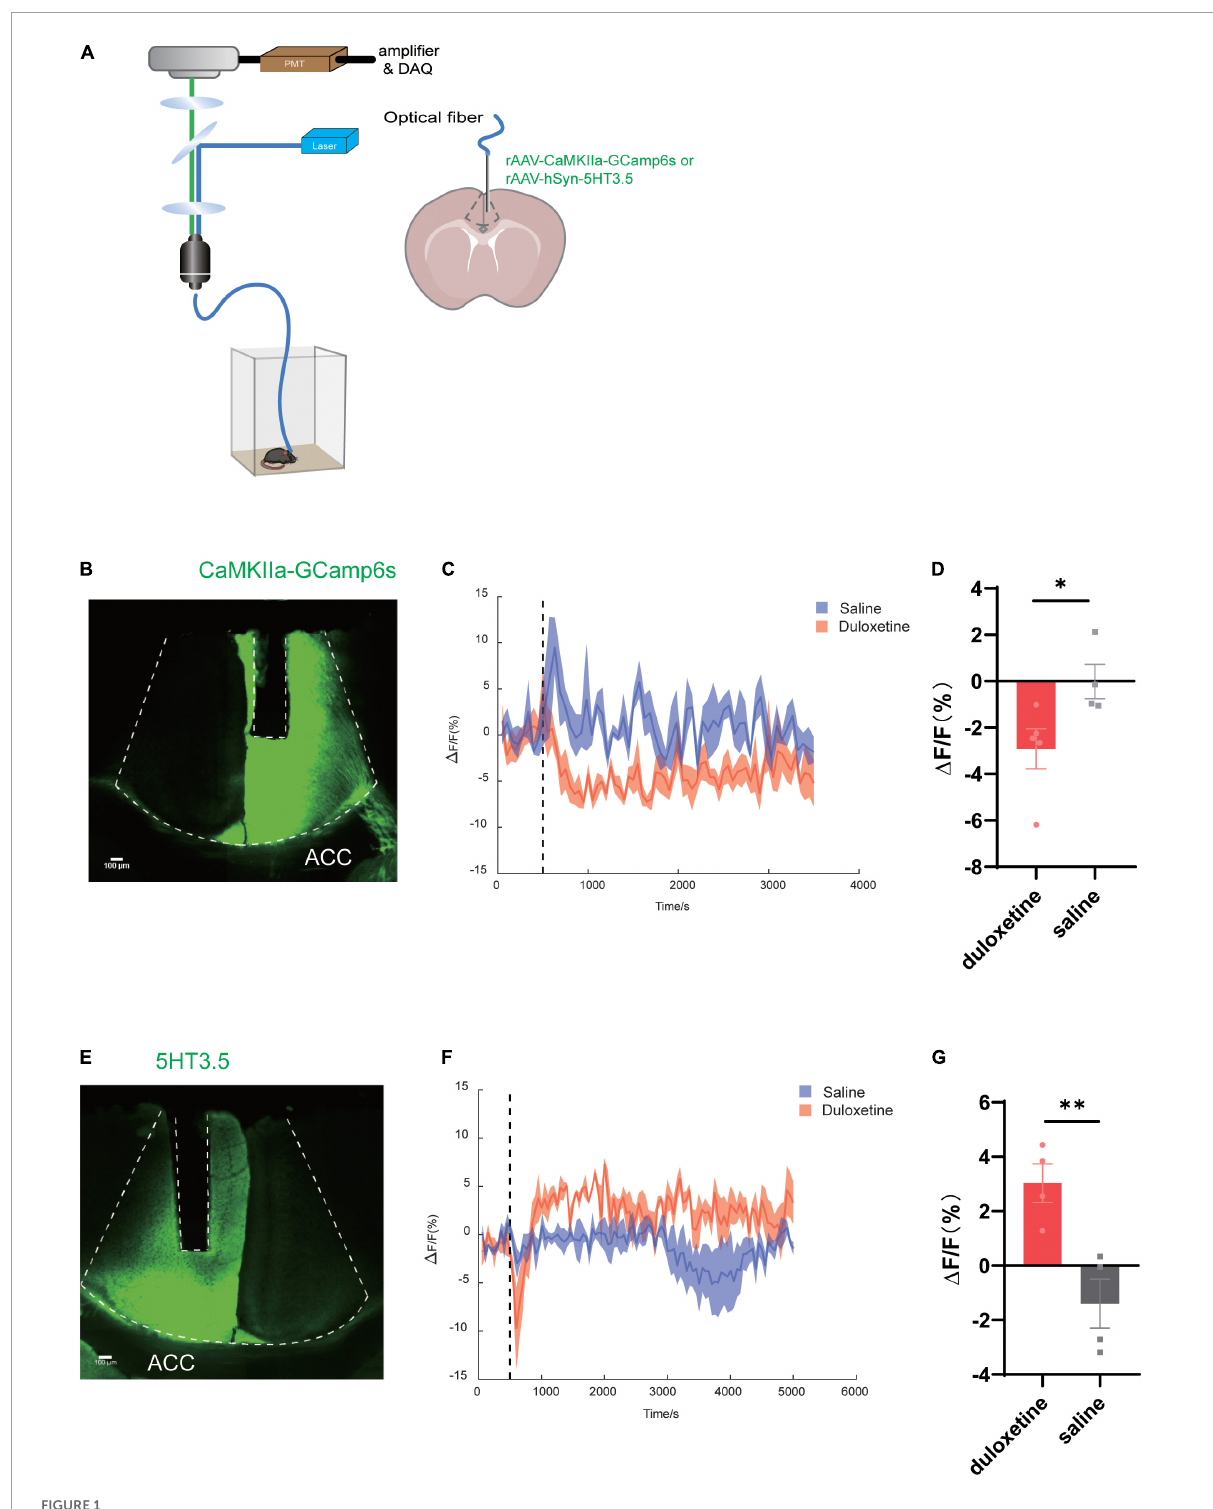
FIGURE1 Duloxetine increases serotonin concentration while deactivating glutamatergic neurons in anterior cingulate cortex (ACC). (A) Schematic diagram of the experimental procedure for fiber photometry of 5-HT sensor fluorescence signals and Ca 2 + signal recording of CaMKIIa-Gcamp6s of mice ACC. (B) Image of CaMKIIa-Gcamp6s and the fiber channel in ACC. (C) Fluorescence changes of CaMKIIa-Gcamp6s in ACC after the intraperitoneal injection of duloxetine. (D) Average (cid:49) F/F after saline and duloxetine injection (Duloxetine n = 5, saline n = 4, p = 0.0434, unpaired t -test). (E) Image of the 5-HT sensor and the fiber channel in ACC. (F) Fluorescence changes of the 5-HT sensor in ACC after the intraperitoneal injection of duloxetine. (G) Average (cid:49) F/F after saline and duloxetine injection ( n = 4, p = 0.0083, unpaired t